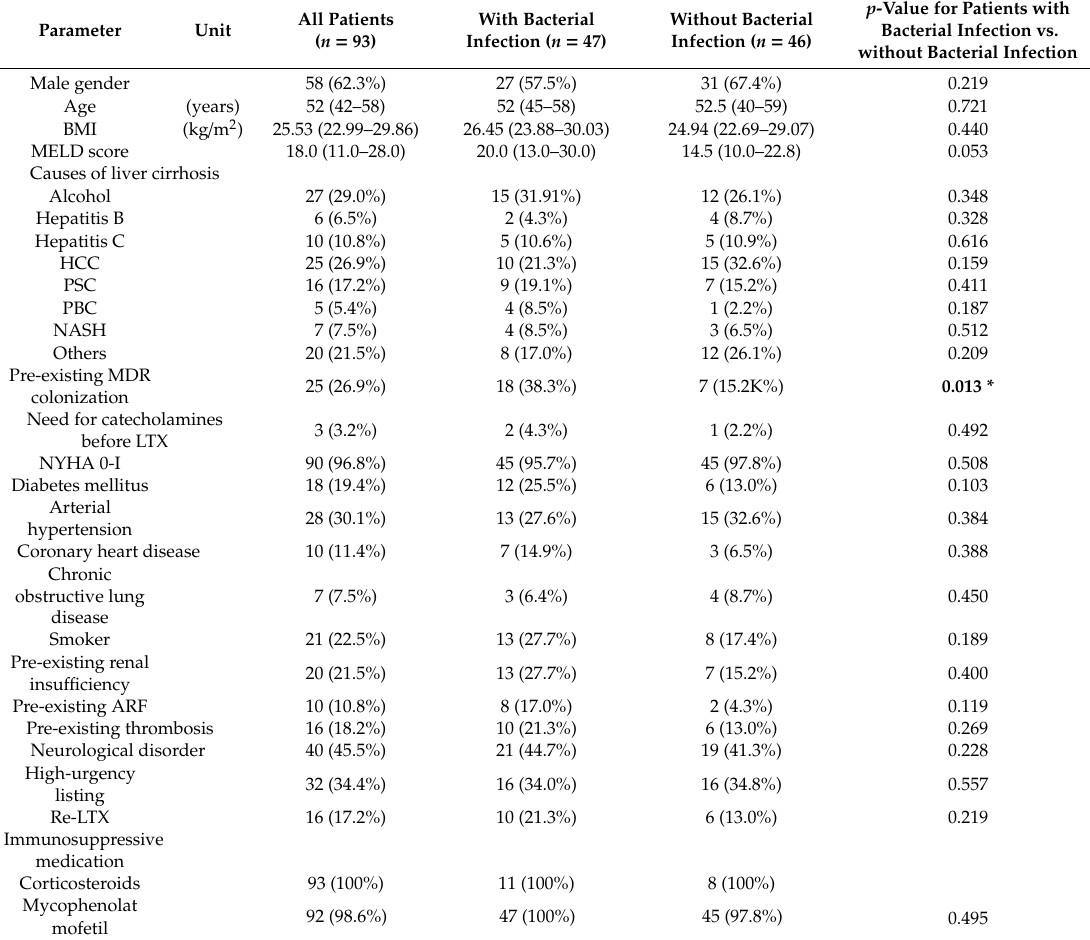
Table 1. Baseline Demographic Data of All Patients and Bacterial Infection